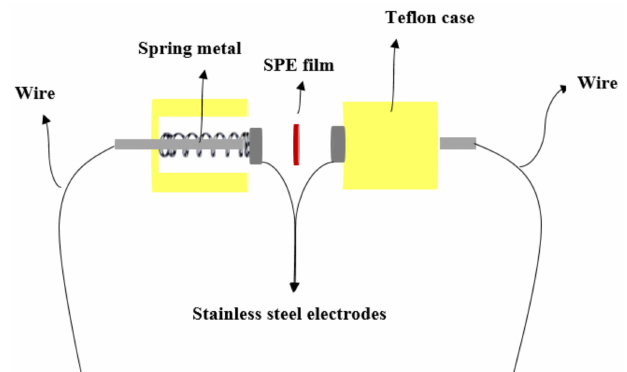
Figure 17. Schematic the stainless-steel